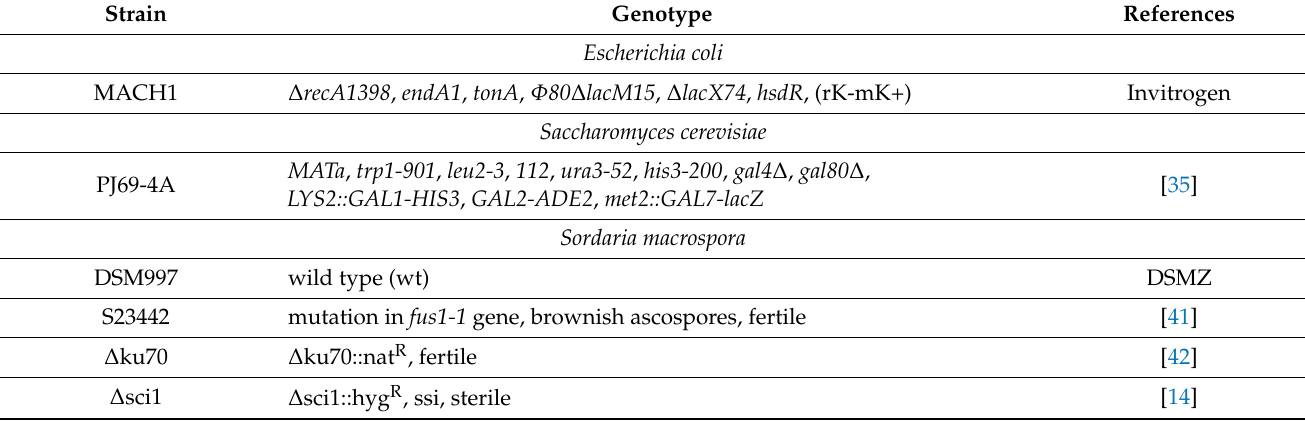
Table 1. Strains used and generated in this